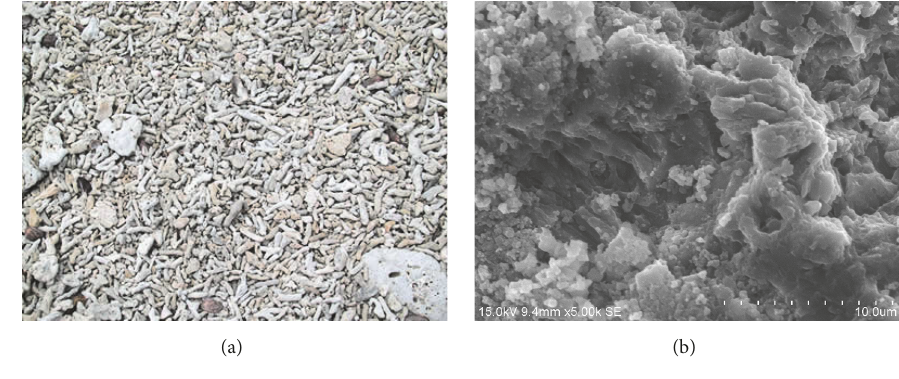
Figure 2: The images of coral aggregate in China.